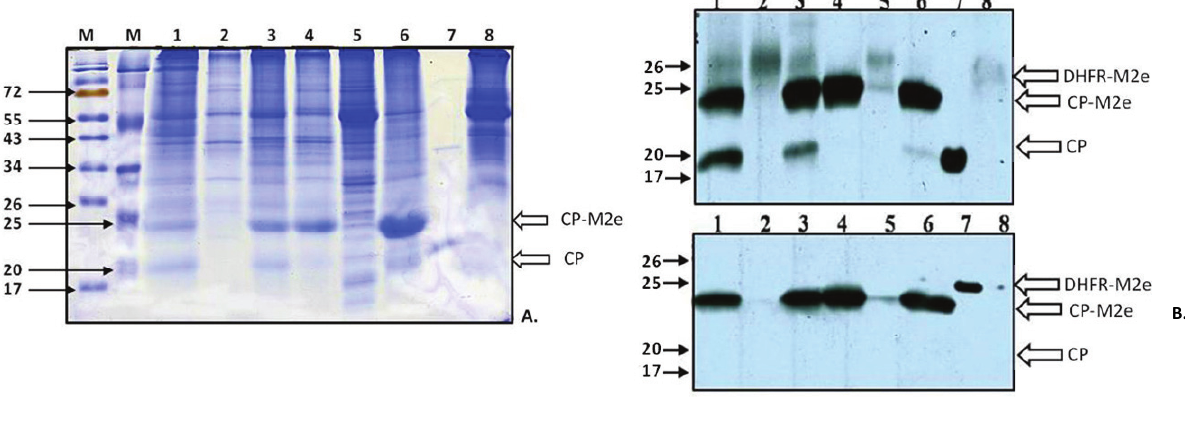
DHFR-M2e); 8 : negative control extract of non-infected Nicotiana benthamiana , 1.5 mg of plant tissue. White arrows indicate the zones corresponded to DHFR-M2e, CP-M2e and CP